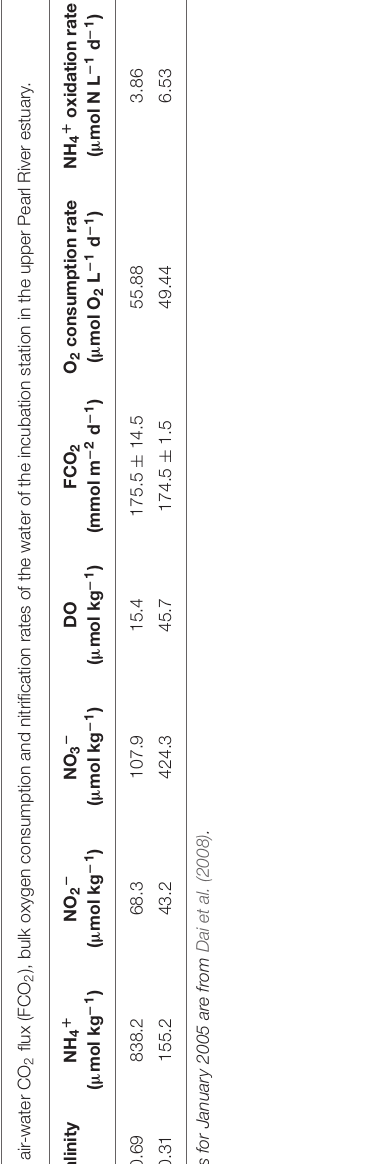
2019, respectively) were not the river end-member values. The freshwater in the Guangzhou region was mostly from a branch of the North River. DIC and TA in the North River were 1587.5 and 1533.5 µ mol kg − 1 in January 2005 and 1575.4 and 1516.6 µ mol kg − 1 in January 2019 (Guo et al., unpublished data). DIC and TA in the East River were much lower. Therefore, there were local DIC and TA additions (1735.6 and 1549.2 µ mol kg − 1 additions in January 2005 and 707.4 and 539.5 µ mol kg − 1 additions in January 2019) in the Guangzhou region of the upper